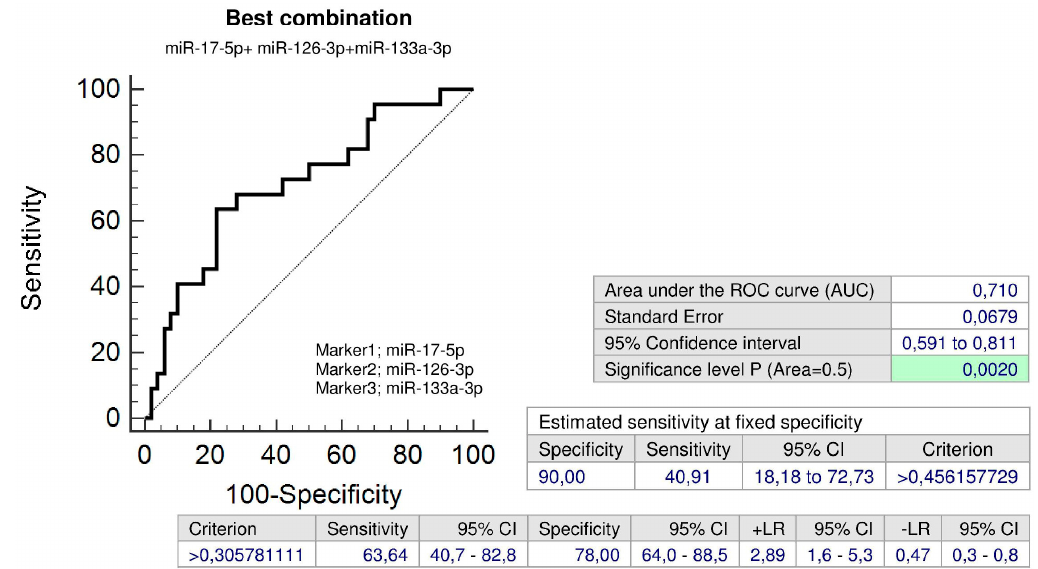
Figure 16. Combined postnatal screening of microRNAs in the identification of children with abnormal postnatal clinical findings descending from FGR pregnancies. Postnatal screening based on the combination of miR-17-5p, miR-126-3p and miR-133a-3p showed the highest accuracy for the identification of children with abnormal clinical findings with a prior exposure to FGR at a higher risk of later development of cardiovascular/cerebrovascular diseases.